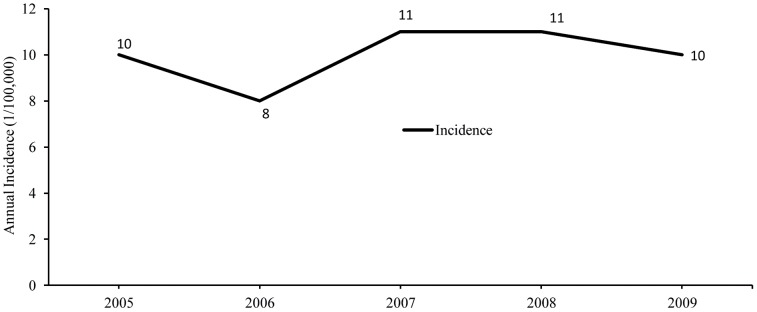
Annual typhoid incidence.